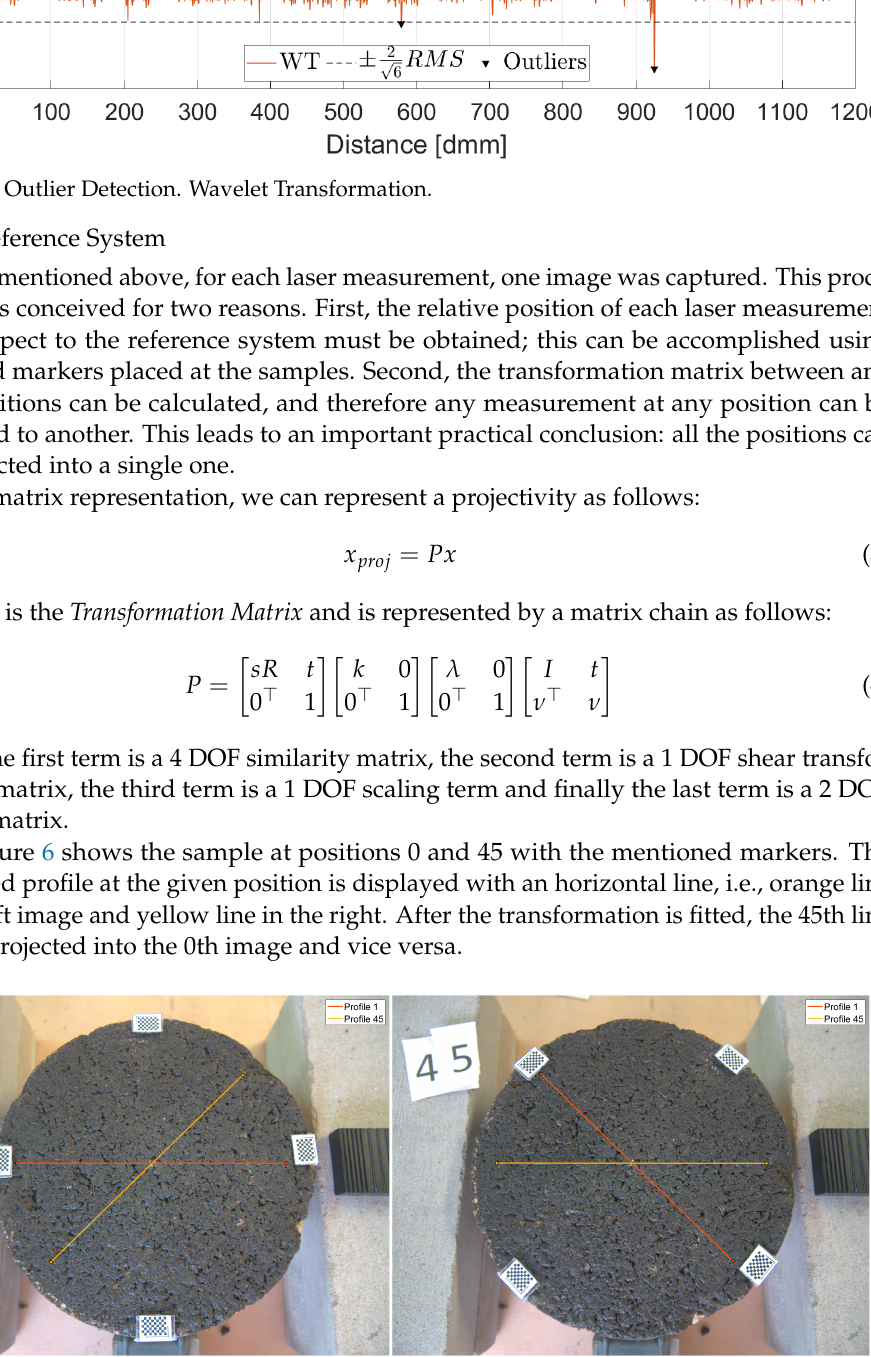
Figure 6. Projection of measurements at different positions. Left: 0th position, measured profile in orange (horizontal), projected profile in yellow (45°). Right: 45th position, measured profile in yellow (horizontal), projected profile in orange